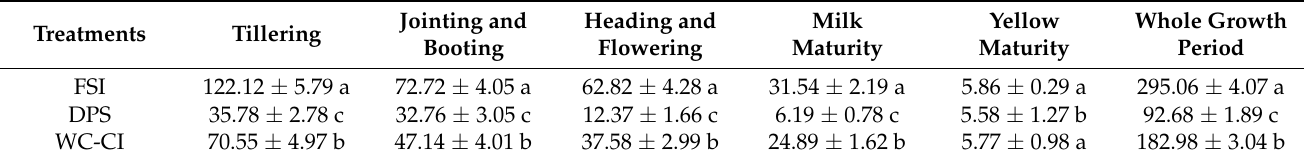
Table 4. The deep percolation under different irrigation and drainage modes (mm).